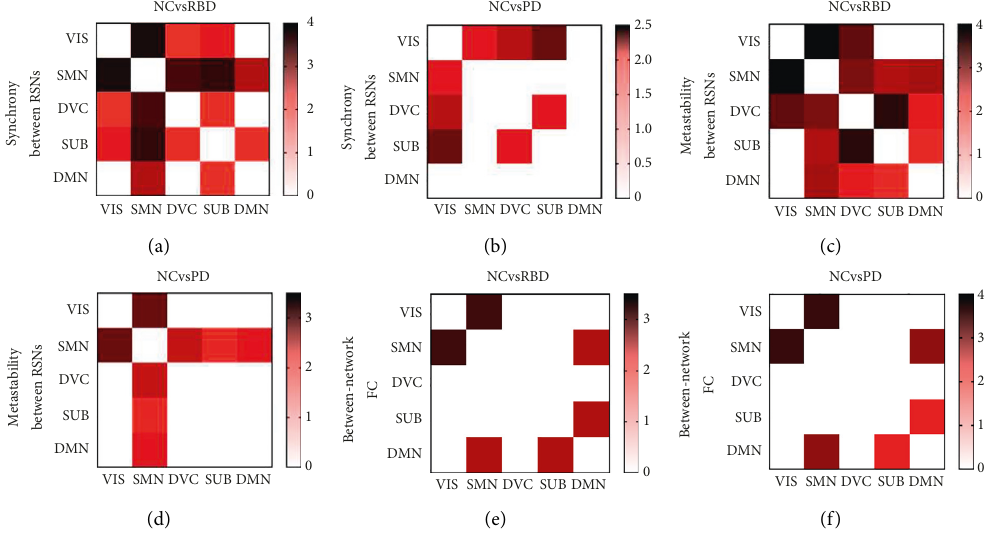
Figure 4: The differences in interaction RSNs between groups. (a) The difference in synchrony between RSNs (NC vs. RBD). (b) The difference in synchrony between RSNs (NC vs. PD). (c) The difference in metastability between RSN (NC vs. RBD). (d) The difference in metastability between RSNs (NC vs. PD). (e) The difference in between-network FC (NC vs. RBD). (f) The difference in between-network FC (NC and RBD); only significant columns are shown ( p 0 . 05, corrected); the value on the color bar represents the t <